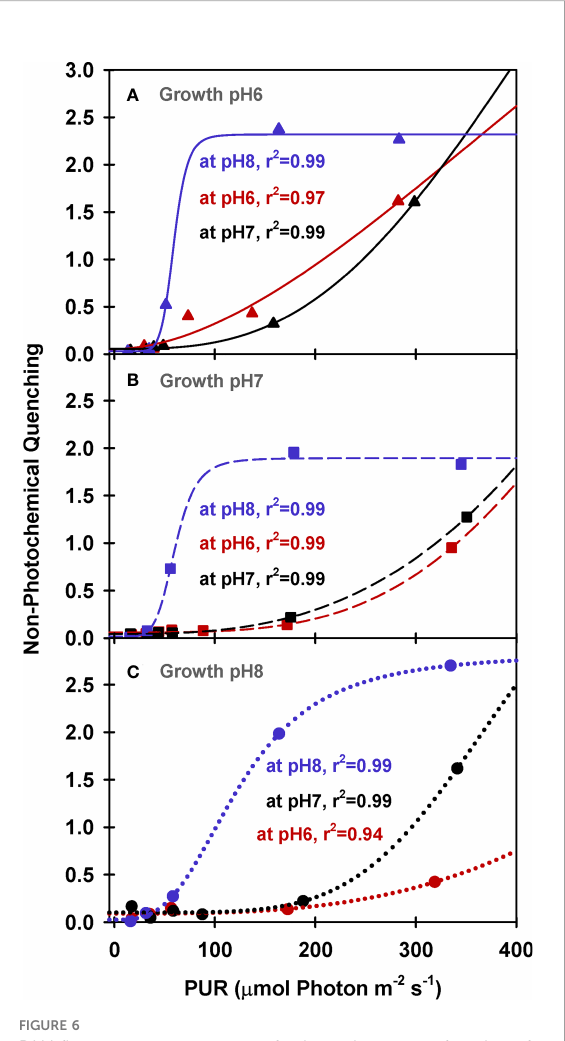
FIGURE 5 PAM fl uorescence parameters of eelgrass leaves as a function of absorbed irradiance. PAM fl uorescence measurements were performed at different pH/CO 2 levels (red: pH6, black: pH7, blue: pH8) using leaves grown at pH6 (2121 µ M CO 2(aq) ) (A) , pH7 (371 µ M CO µ M CO 2(aq) ) (B) and ambient pH8 (55 2(aq) ) (C) . Curves were fi t using Equation (9).